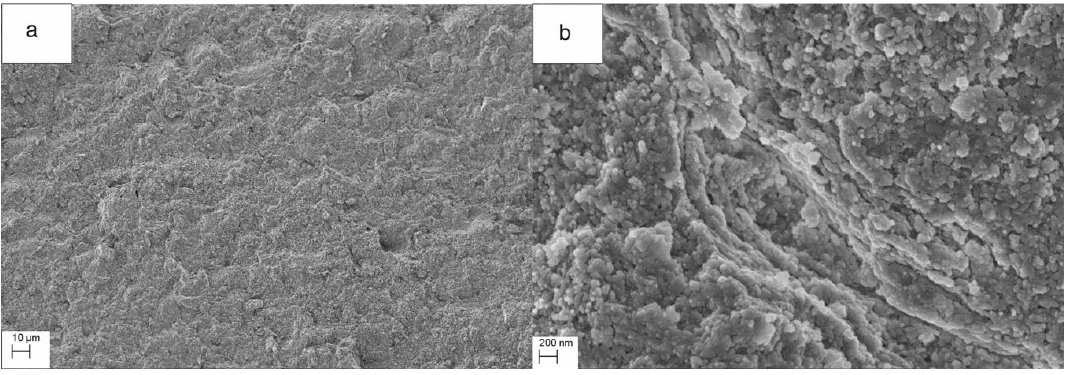
Figure 6. Fracture surface morphology of HAP NPs-PLA dense composites after a bending test for variant III, ( a ) Fracture at the magnification of 500 × , ( b ) Composite structure at the magnification of 100,000 ×